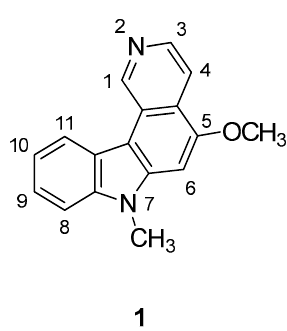
Figure 1. Structure of 5-methoxy-7-methyl-7 H -pyrido[4,3-c]carbazole ( 1 ).